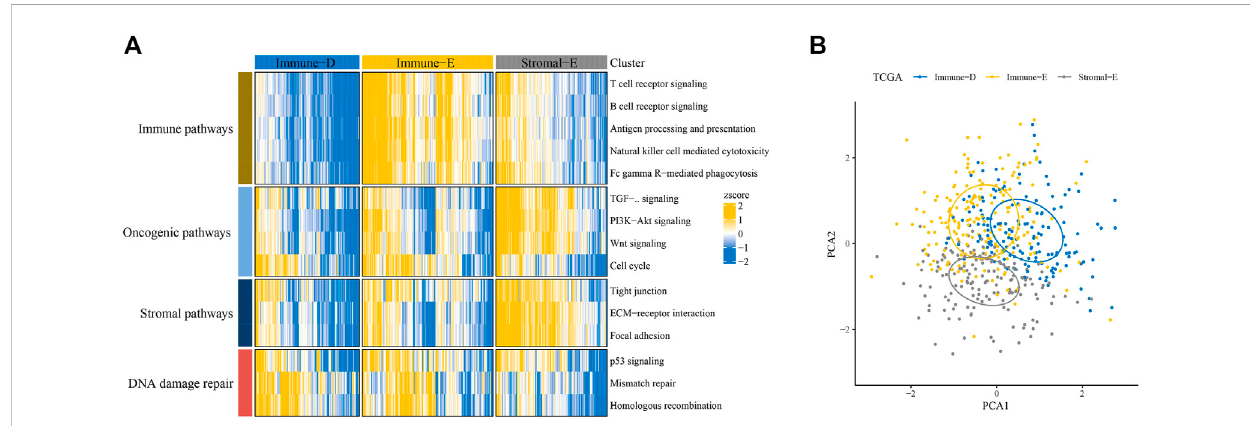
FIGURE 1 Identi fi cation of three molecular subtypes in thyroid cancer. (A) Identi fi cation of Immune-Enrich, Stromal-Enrich, and Immune-Deprived subtypes in the TCGA dataset. (B) Principal component analyses of the three molecular